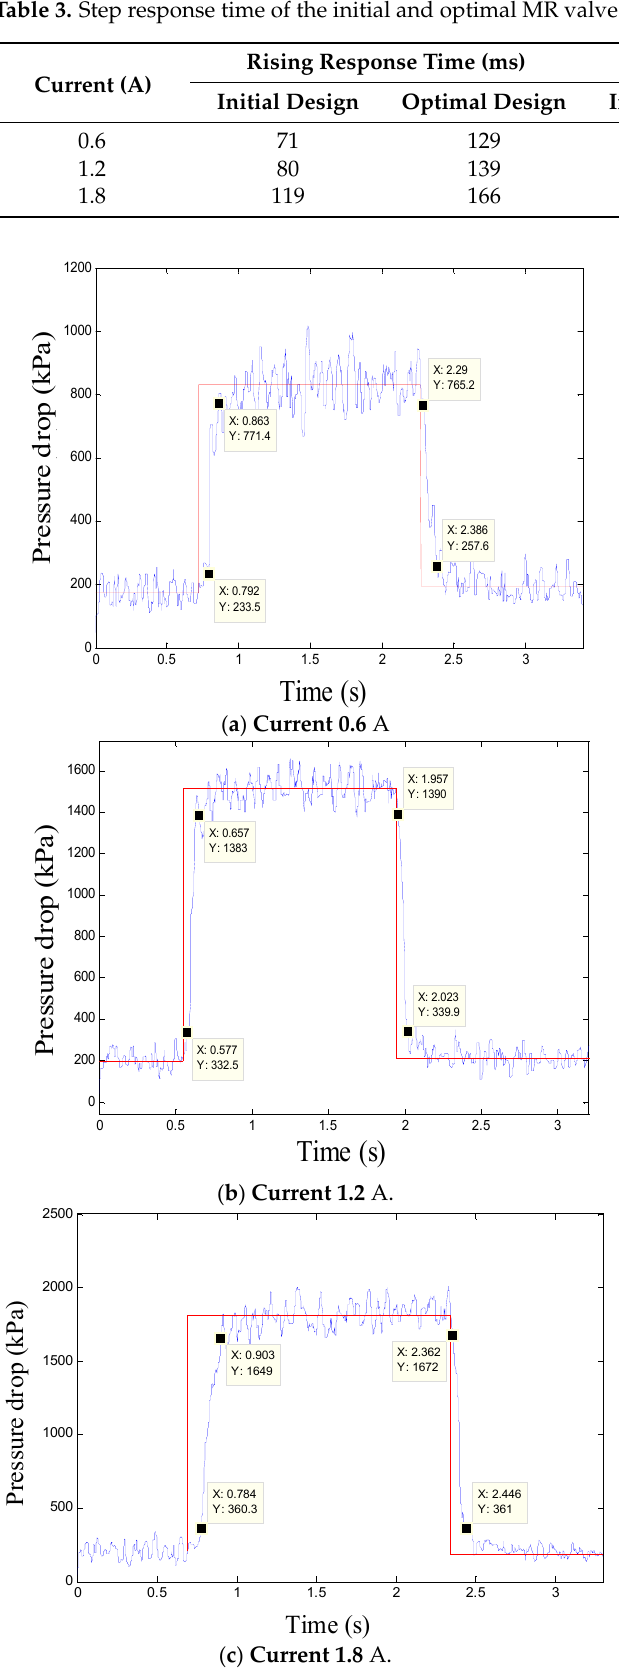
Figure 24. Step response diagram of the initial radial MR